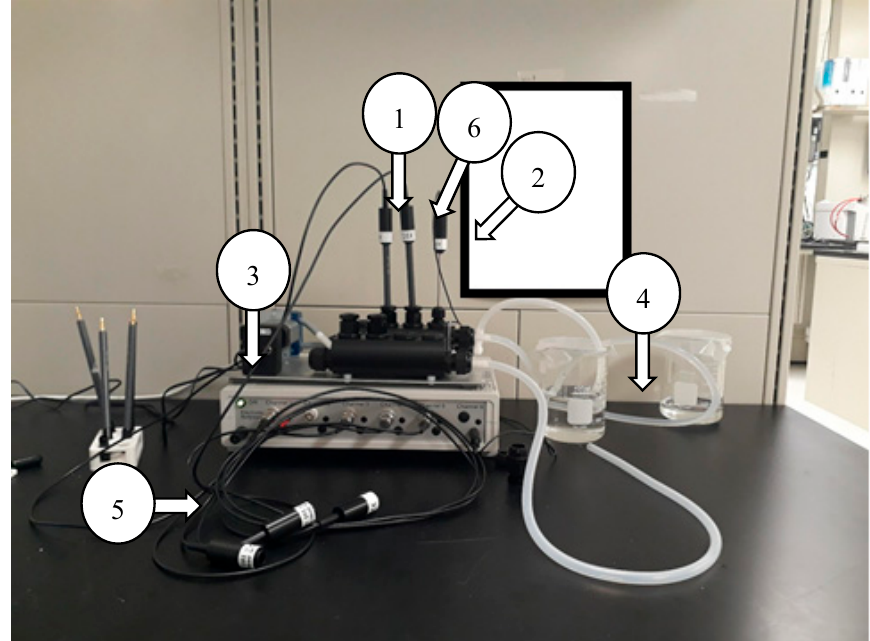
Figure 1. Experimental set-up of Nico2000 ELIT 6-Channel Flow-through Monitor used for drift over time measurements; ( 1 ) ISE ( 2 ) Thermocouple ( 3 ) Peristatic Pump ( 4 ) Test Solution ( 5 ) Communication Channel ( 6 ) Reference Electrode.